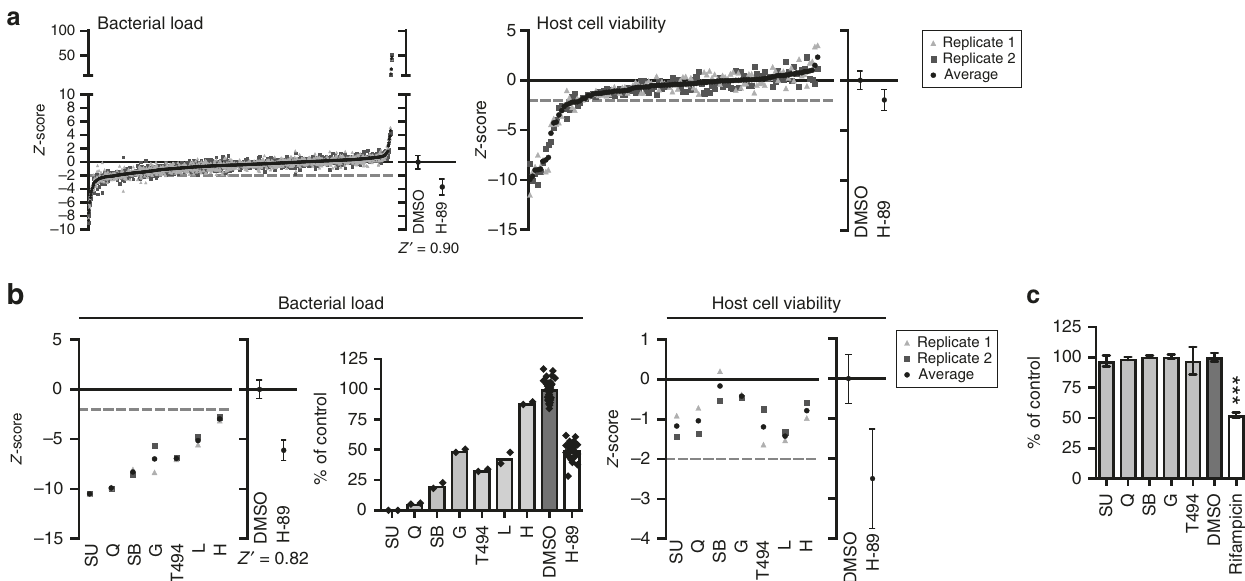
Fig. 2 Identi fi cation of host-directed compounds inhibiting Mtb . a Results of a screen of 1260 compounds of the LOPAC library at 10 µ M in the MelJuSo- Mtb infection model using Mtb constitutively expressing stable DsRed, expressed as z -scores (left panel). Individual replicates of the screened compounds are shown as gray points and the average z -score for each compound is displayed in black. The average z -score and standard deviation of the controls (DMSO and H-89) are displayed separately and the assay window expressed as a Z ′ -factor is shown below. Cell viability z -scores of the 110 hit compounds are shown in the right panel. The dashed line depicts a cutoff at a z -score of − 2. b A rescreen of the hit compounds that were superior to H-89 without affecting cell viability at 10 µ M is shown as in a . The bacterial load is expressed as a z -score in the utmost left panel and as a percentage of control value in the middle panel to indicate the extent of bacterial inhibition. Individual screening datapoints are overlayed on the bar graph. Compound abbreviations: SU = SU 6656, Q = quinacrine, SB = SB 216763, G = GW5074, T494 = tyrphostin AG 494, L = L-594,881, H = haloperidol. c Mtb broth culture treated for 6 days with the fi ve hit compounds of the Mtb screen at 10 µ M. Rifampicin (20 μ g/ml) was used as a positive control. The average bacterial density ± standard deviation of four replicates from a representative experiment (out of three experiments) is shown, expressed as a percentage of the DMSO control. Statistically signi fi cant difference compared to DMSO was tested using a one-way ANOVA (F (6,25) = 81.66; *** p value <